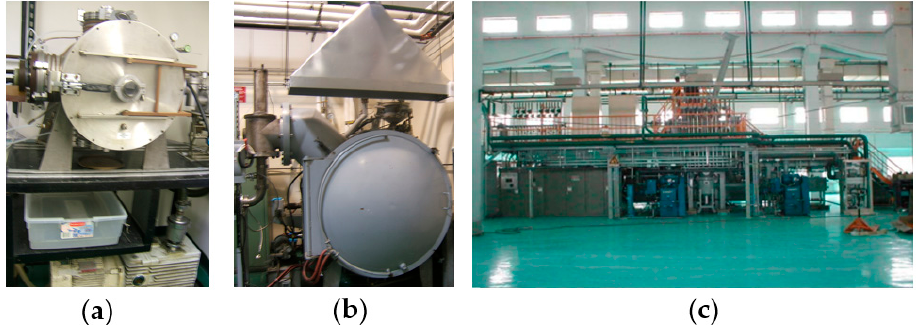
Figure 2. Images of ( a ) a 200 g, ( b ) 60 kg, and ( c ) 1 ton vacuum induction melting (VIM) furnaces.